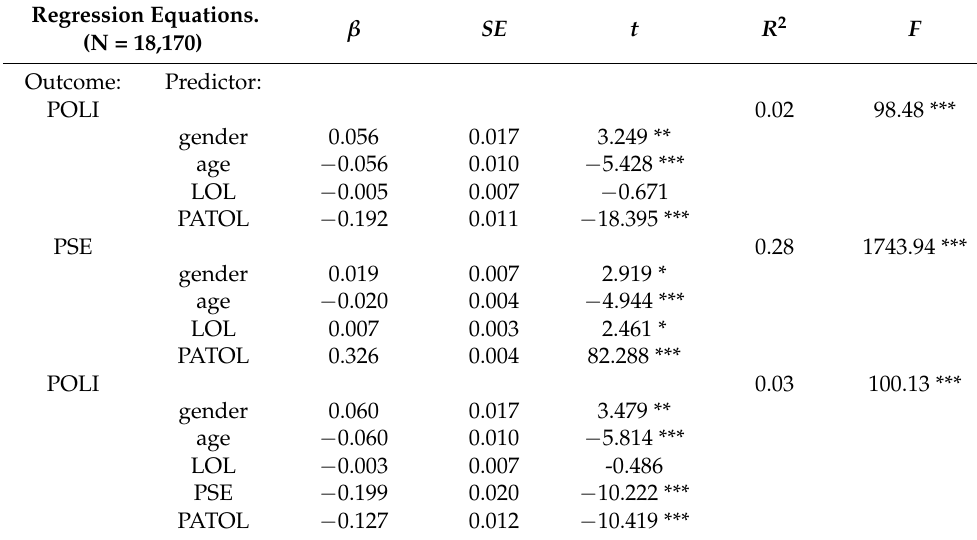
Table 3. Regressions testing PSE as a mediator in the relationship between PATOL and POLI.